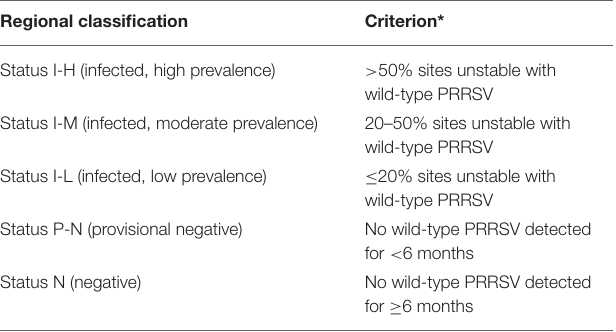
TABLE 1 | Regional classification based on prevalence of wild-type PRRSV unstable sites. Regional